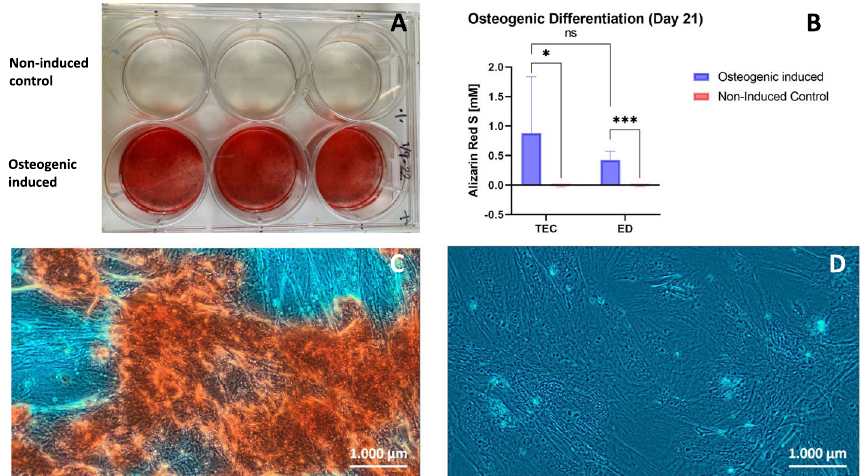
Fig. 4 Alizarin Red S staining of osteogenic induced and non-induced cells. ( A ) Representative image of monolayer stem cells from cryopreserved microfragmented adipose tissue when isolated by tissue explant culture and cultured in osteogenic induction medium or normal expansion medium (negative control) in 6-wells for 21 days and stained with Alizarin Red S. ( B ) Box plot of Alizarin Red S concentration [mM] of osteogenic induced and non-induced paired stem cells from cryopreserved microfragmented adipose tissue when isolated with tissue explant culture (TEC) and enzymatic digestion (ED), respectively. ns: non-significant, *: p < 0.05, ***: p < 0.001 when analyzed with paired t-tests. ( C ) Phase contrast image (20x) of stem cells from cryopreserved microfragmented adipose tissue when isolated with TEC and stained with Alizarin Red S after 21 days of culture in osteogenic induction medium. Red color shows calcium deposits, and ( D ) after 21 days of culture in normal expansion medium (negative control). Size bars show 1000 µm